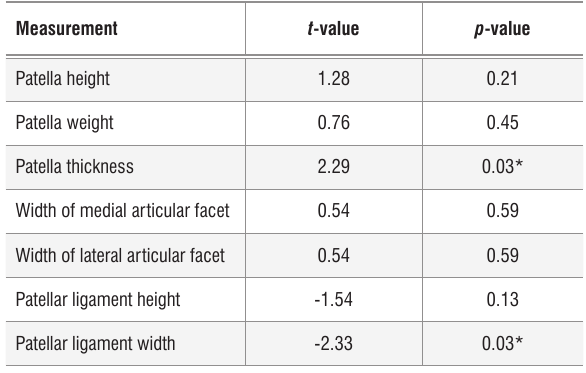
Comparison between the measurements of the left and right knees using a Student’s t -test